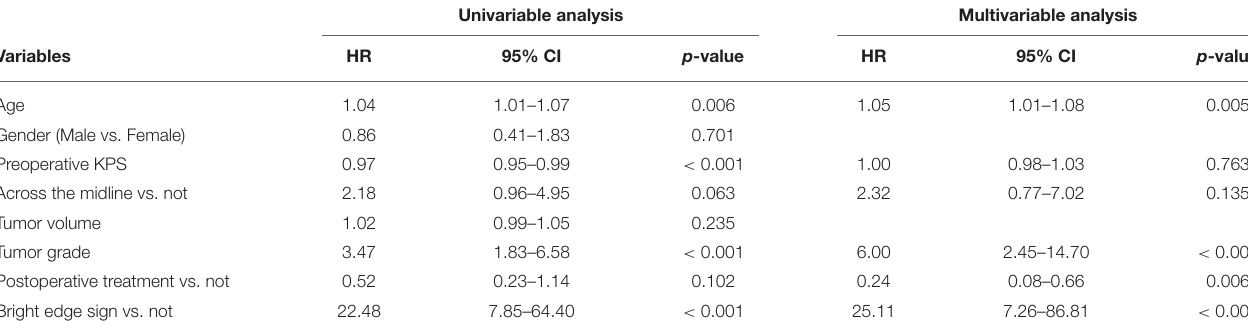
TABLE 2 | Univariable and multivariable Cox model of variables in predicting overall survival in glioma